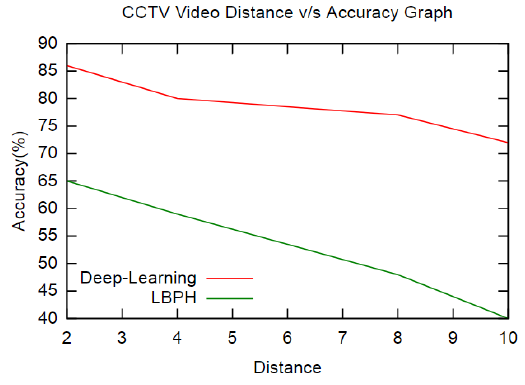
Figure 8 . CCTV video Distance Comparison